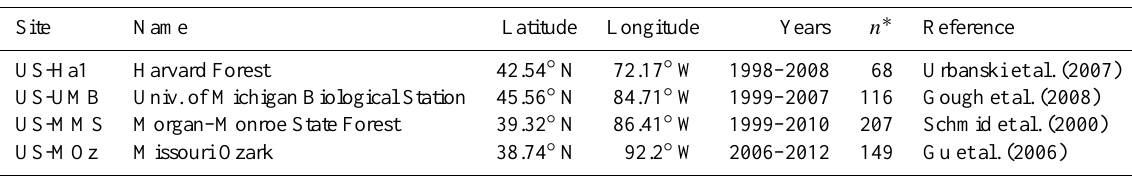
∗ n denotes the number of records.